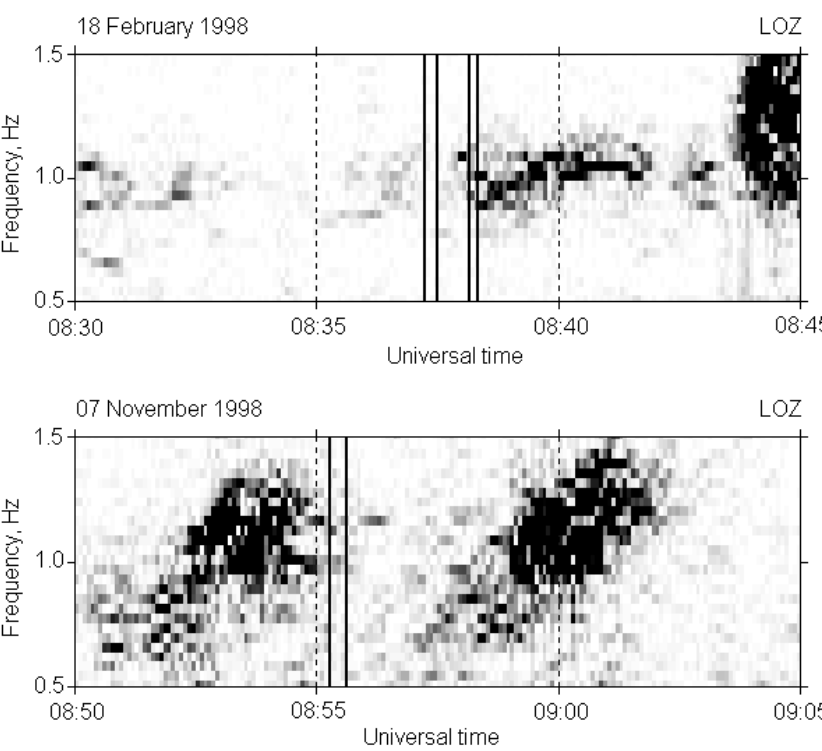
Fig. 8. Excitation of the ULF burst in relation to the moment of observation of hot protons (the interval of proton precipitation is marked with two vertical lines).